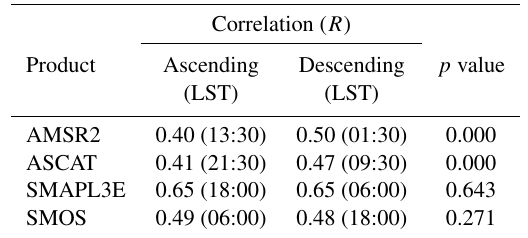
Table 2. Median Pearson correlations ( R ) between in situ measure- ments and retrievals from ascending and descending overpasses for the single-sensor soil moisture products (Table 1). The approximate local solar time (LST) of the overpasses is reported in parenthe- ses. Probability ( p ) values were determined using the Kruskal and Wallis (1952) test. A small p value indicates that the difference in median R is unlikely to be due to